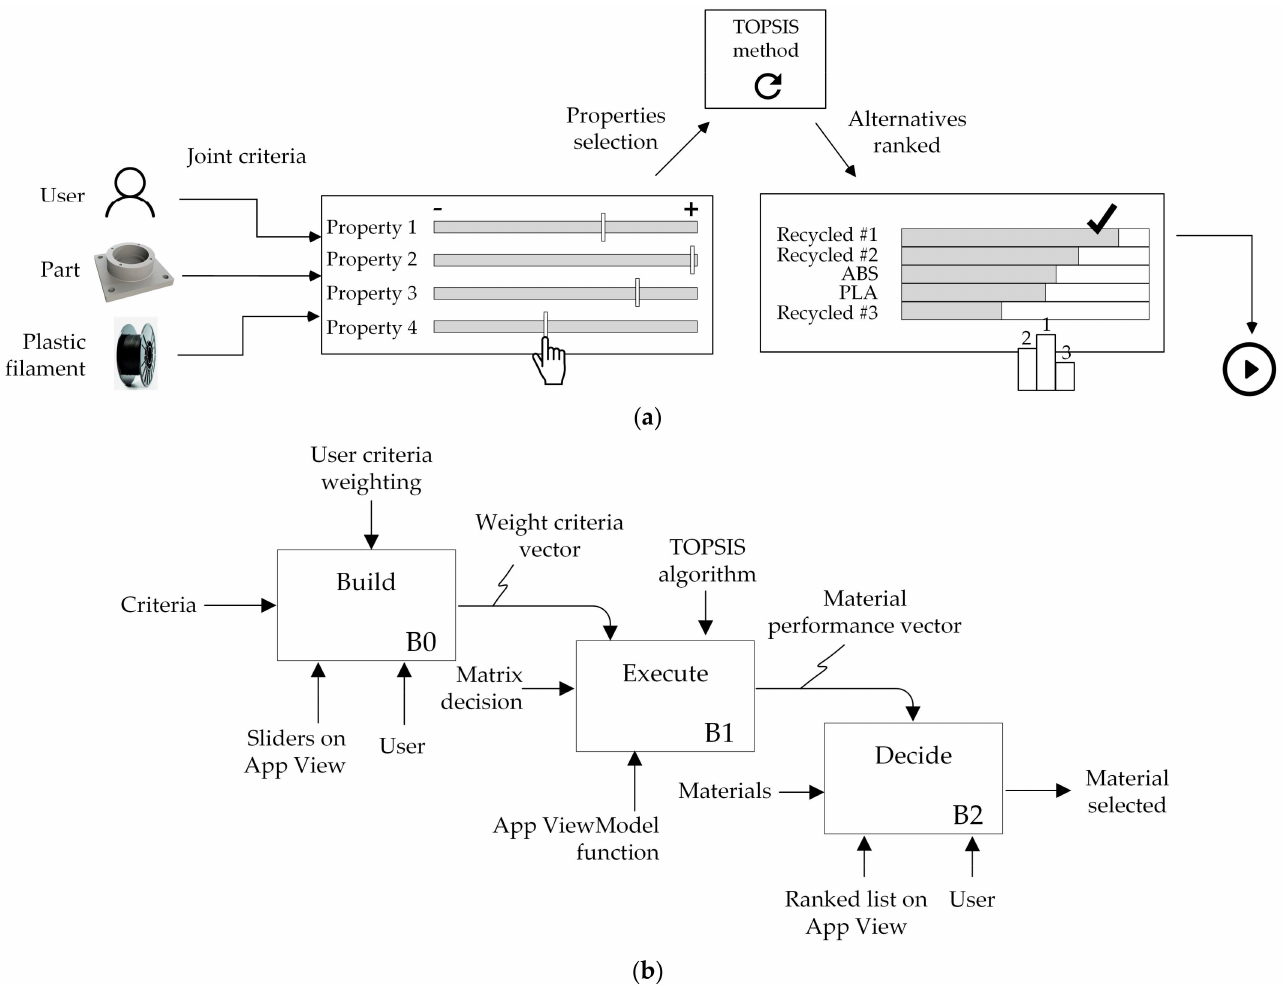
Figure 6. Material selection support process. ( a ) Graphic representation of the selection process (View); ( b ) IDEF0 diagram (ViewModel and